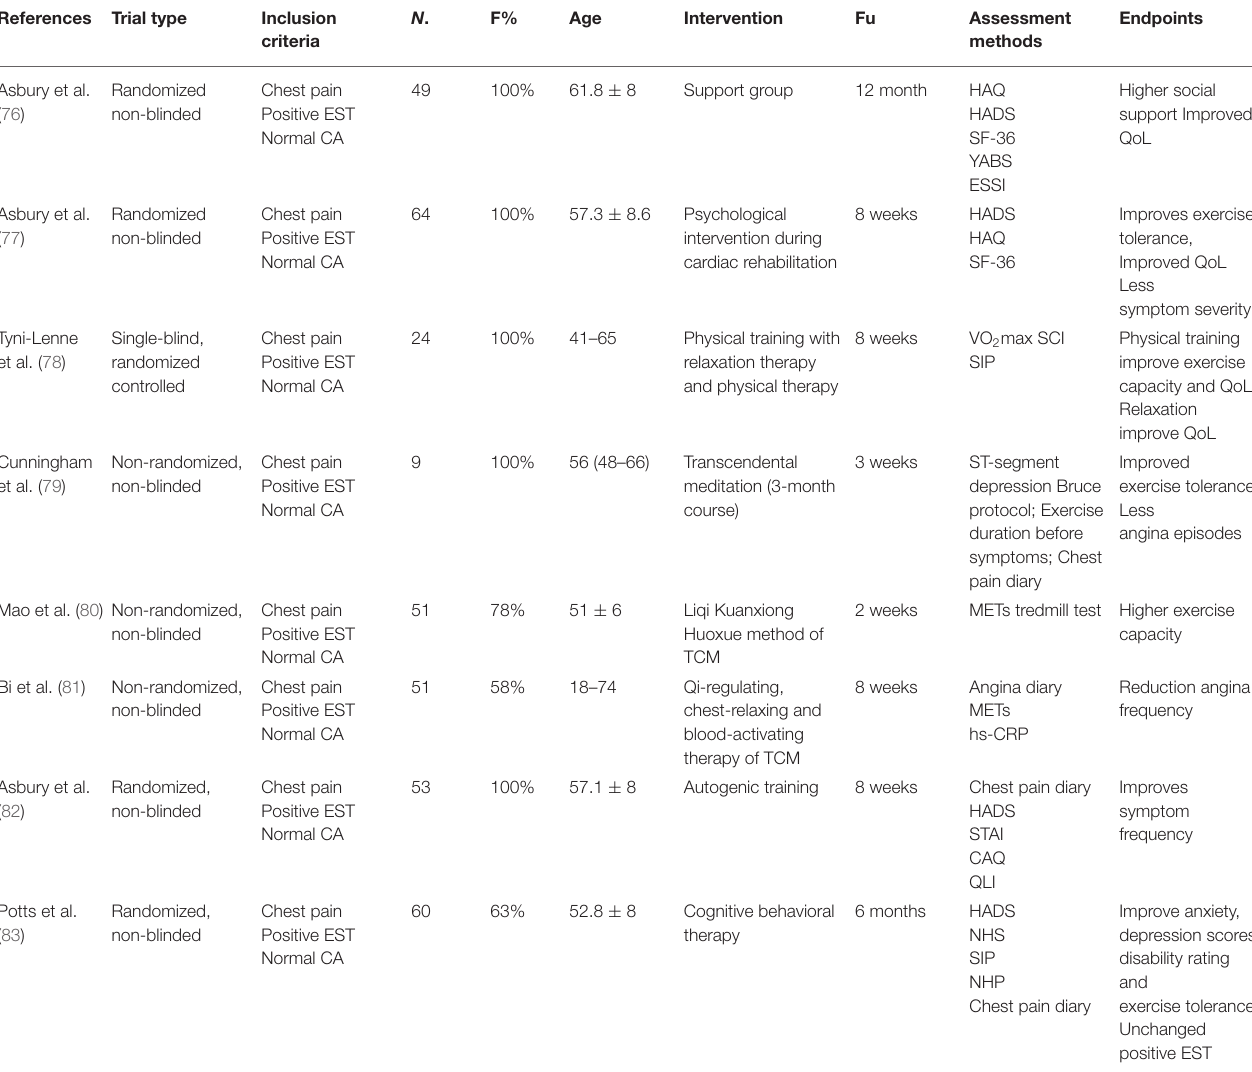
TABLE 1 | Interventional studies investigating psychoeducational intervention in